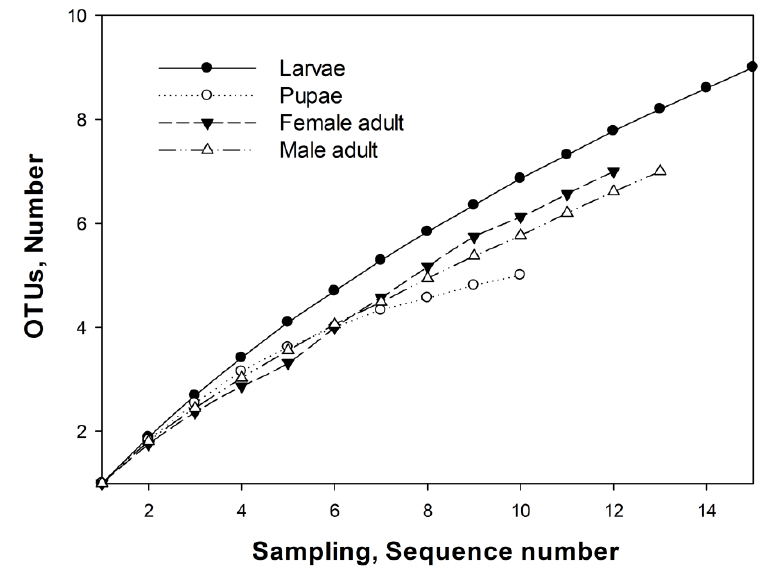
Figure 3. Rarefaction curves of bacterial 16S rRNA sequences in the gut of Dendroctonus armandi larvae, pupae, adult females and males, calculated using MOTHUR OUTs . The plot showed the number of new bacterial species as a function of the number 0.03 of clones